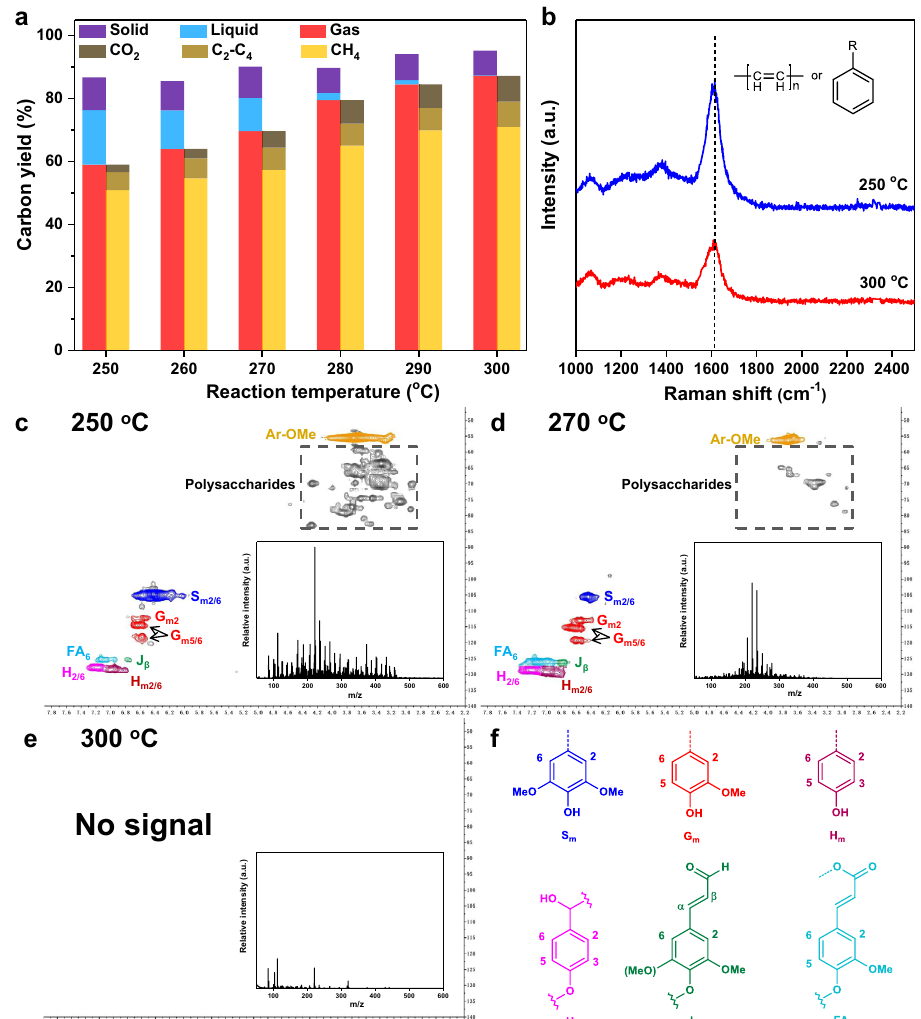
Fig. 1 Catalytic conversion of beech sawdust over the prepared nickel-based alloy catalyst. a Carbon yield of solid, liquid, and gas products and the distribution of gas products at various temperatures. b Analysis of solid carbon species deposited on the used catalysts by UV Raman spectroscopy. The peak at 1615 cm − 1 was assigned to the stretching vibration of C = C. c 2D HSQC NMR and MALDI-TOF-MS (the inset) analysis of the liquid products after the reaction at 250 °C. d 270°C. e 300 °C. f The possible lignin structure in the liquid products. Reaction condition: 1.0 g beech sawdust, 5.2 mmol nickel- based alloy catalyst (based on nickel), 20 mL H 2 O, 4 MPa H 2 , 5 h. The gas, solid, and liquid products were quanti fi ed by gas chromatography, total organic carbon instrument and thermogravimetric analysis, respectively. The carbon yield was calculated according to the mole numbers of carbon in the reaction products and